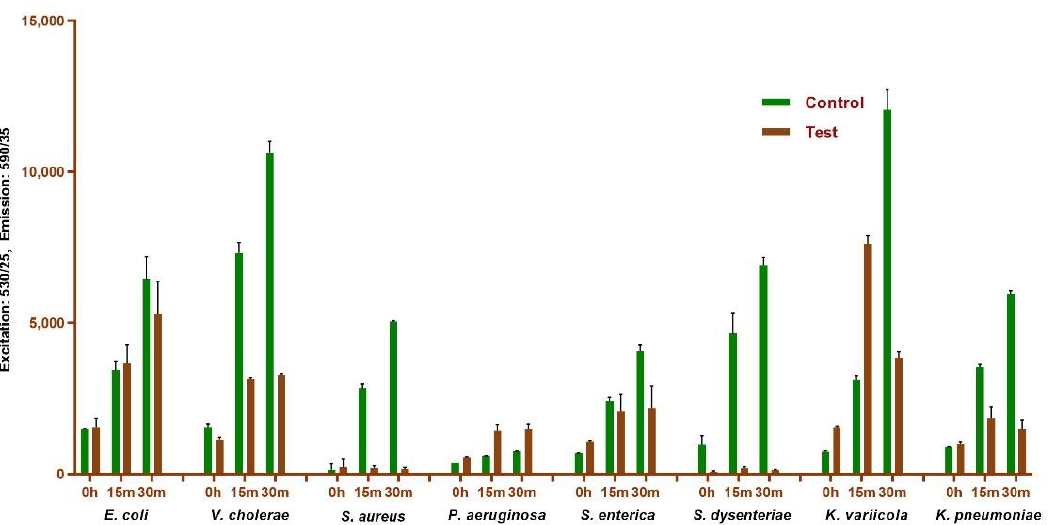
Figure 1. Effect of A. niger culture filtrate (ACF) on the growth of eight targeted enteric pathogens. The microtiter well plate with cultures (0.4 OD) treated with ACF at a ratio of 1:1 served as test and cultures without ACF were considered as control. Growth is marked as optical density (OD600 nm) measured after 0 h, 2 h, 24 h and 48 h of incubation. Values are the mean ± standard deviation of three replicates.